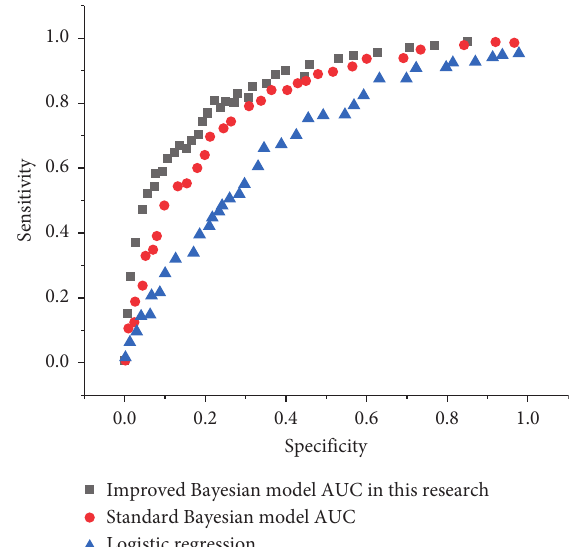
Figure 9: The resolution performance results of the standard Bayesian method, logistic regression method, and improved Bayesian method on the validation data